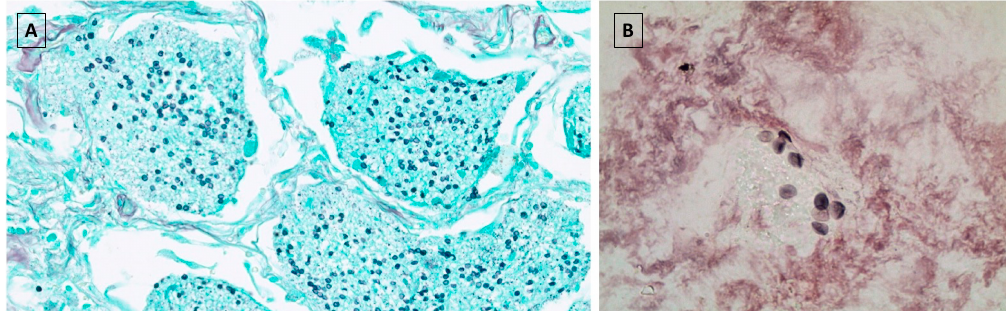
Figure 1. Diagnostic specimens for microbiological demonstration of Pneumocystis jirovecii infection. ( A ) Lung biopsy showing intra-alveolar proteinaceous exudates with the presence of numerous Pneumocystis jirovecci cysts. Grocott methenamine silver stain (at ×400 magnification). ( B ). Induced sputum showing the presence of numerous Pneumocystis jirovecci cysts. Grocott methenamine silver stain (at ×100 magnification).